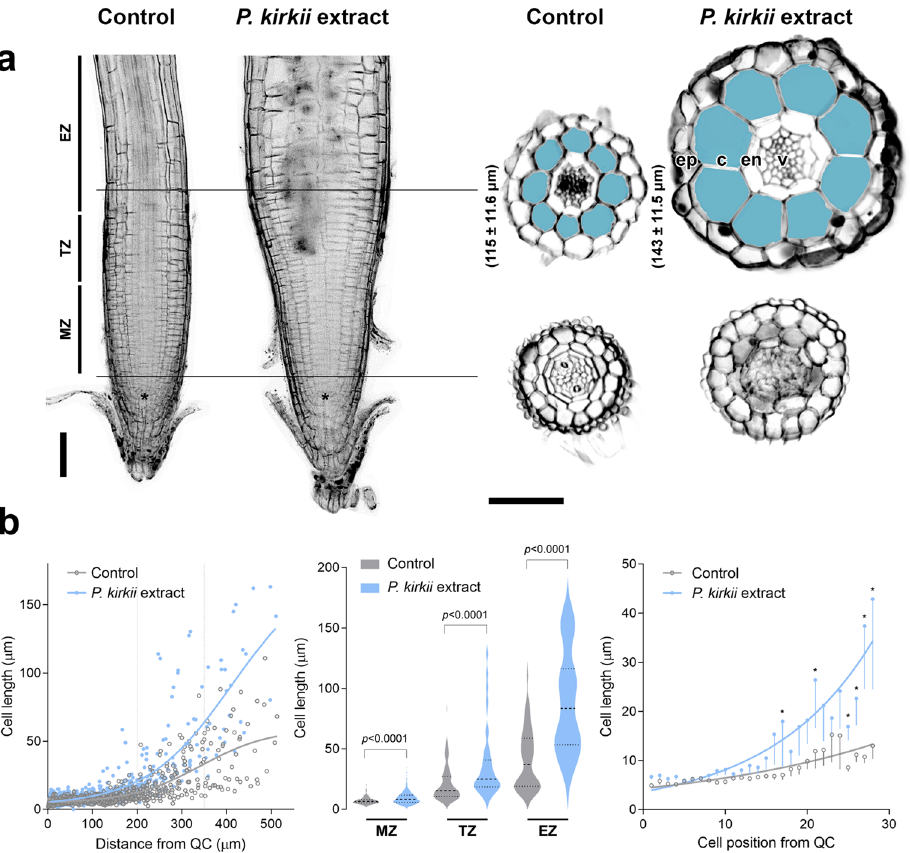
Figure 1. P. kirkii extracts disrupt root anisotropic growth. ( a ) Left, optical longitudinal sections of mPS- PI-stained Arabidopsis roots. Progressive swelling of treated root cells transitioning to the elongation zone is apparent. Asterisks mark the root quiescent centre. Bar = 100 µm. Right, corresponding cross sections highlighting the epidermal and cortical radial expansion in treatment. Numbers in brackets indicate the mean of section diameters with standard deviation (n = 12). v vasculature, en endodermis, c cortex, ep epidermis. Bar = 100 µm. ( b ) Left, cortical cell length in function of the distance to the quiescent center (QC). Dataset represents fifteen seedlings per treatment, curves were fitted with the Gompertz model, circles indicate data distribution. Dotted lines delimit the distinct apical root zones. Middle, cortical cell length in the given root apical zone. Significant differences between treatment and water control were analysed in two-sided unpaired t-tests ( p -values are indicated). Right, cortical cell length in function of the position from QC initials. Data represent mean values; curves were fitted with the exponential growth model, standard errors are indicated. Significant differences between treatment and untreated control for each position were analysed in two-sided unpaired t-tests (* p -value < 0.05). MZ meristematic zone, TZ transition zone, EZ elongation